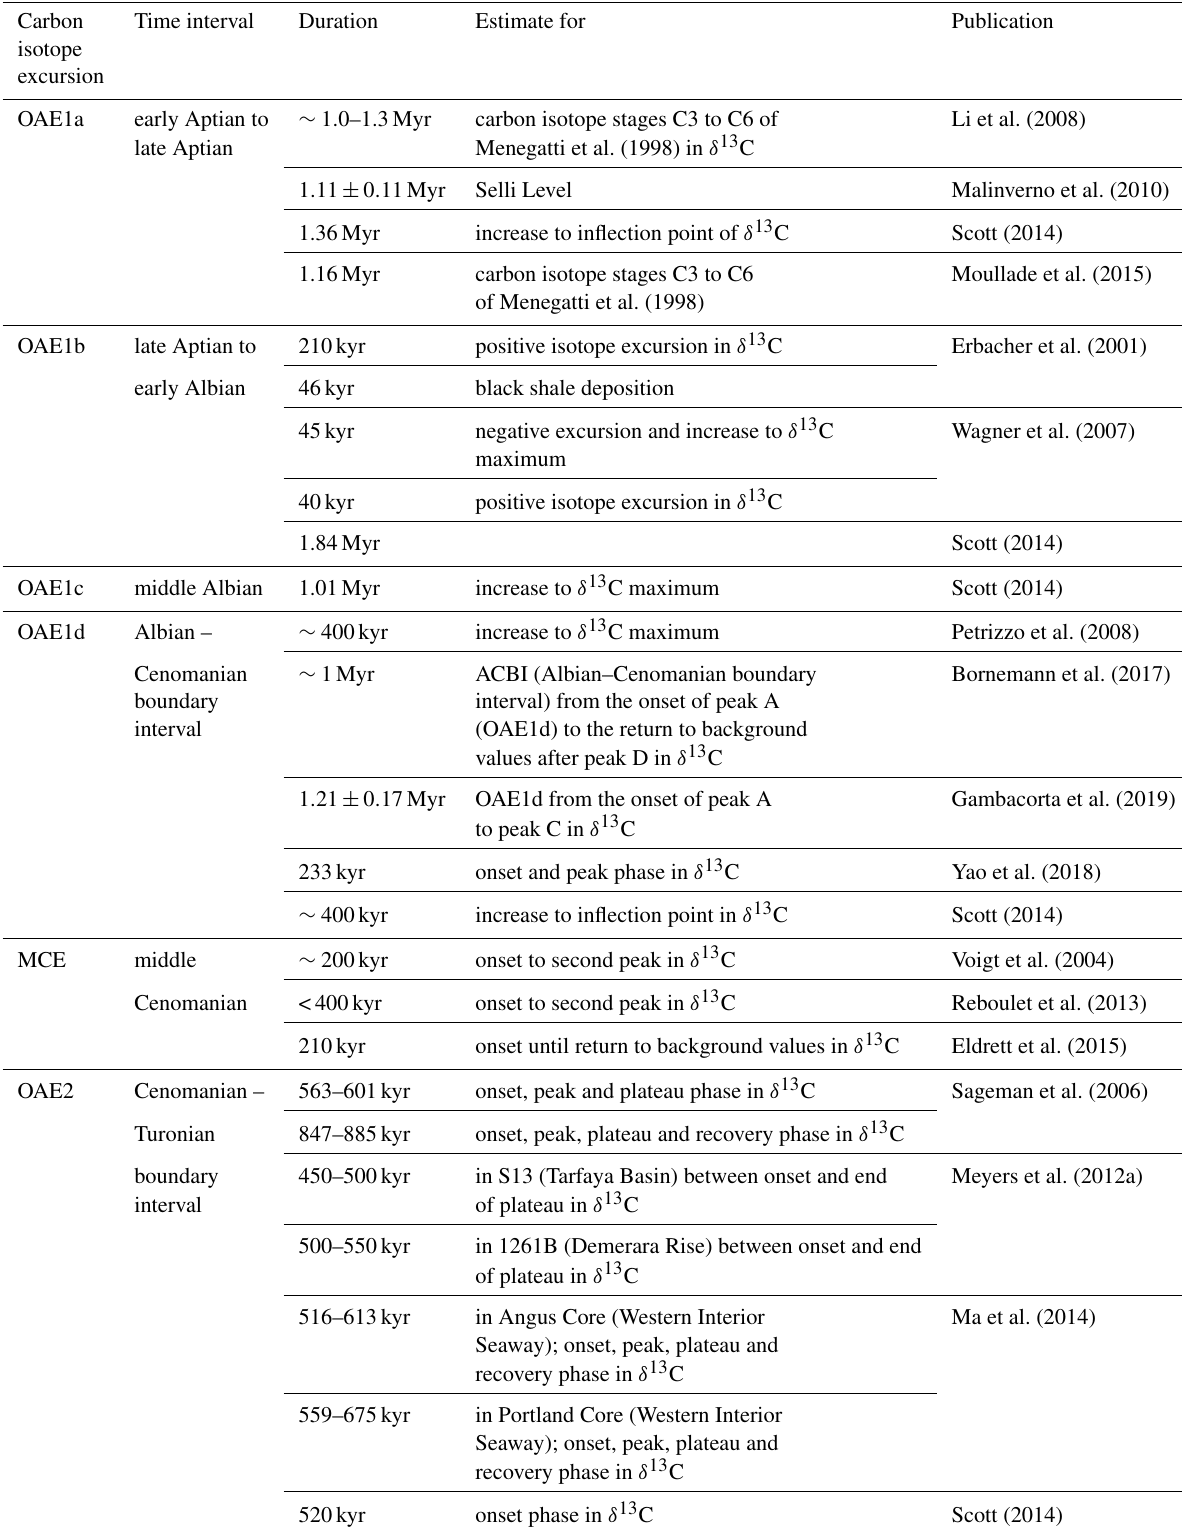
Table 1. Durations of Cretaceous